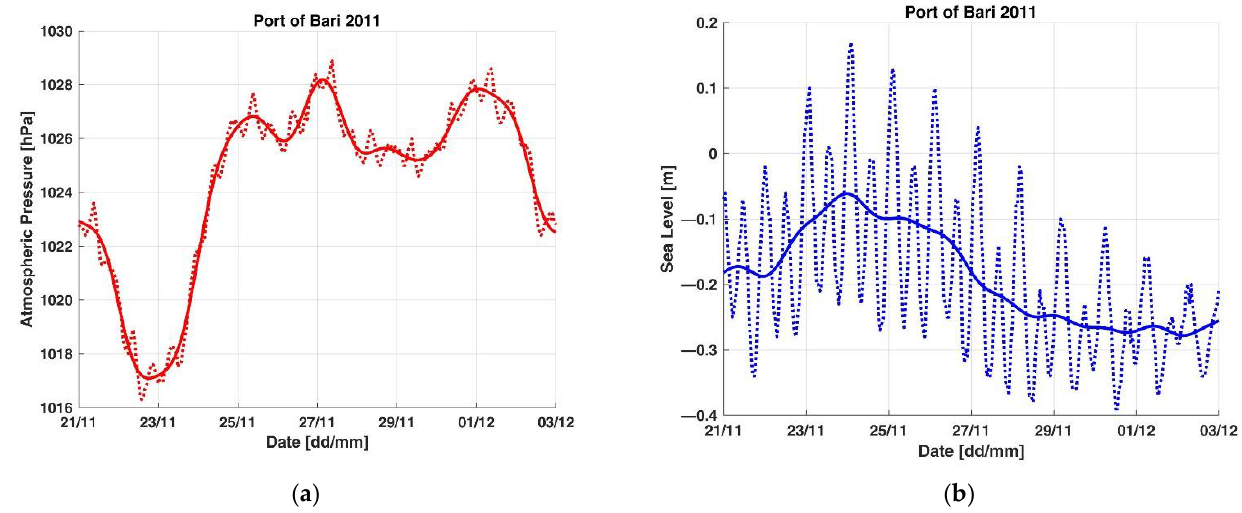
Figure A13. Low-frequency components of meteo-mareographic parameters acquired by ISPRA’s monitoring station in the port of Bari from 21 November to 3 December 2011: ( a ) atmospheric pressure; ( b ) sea level.